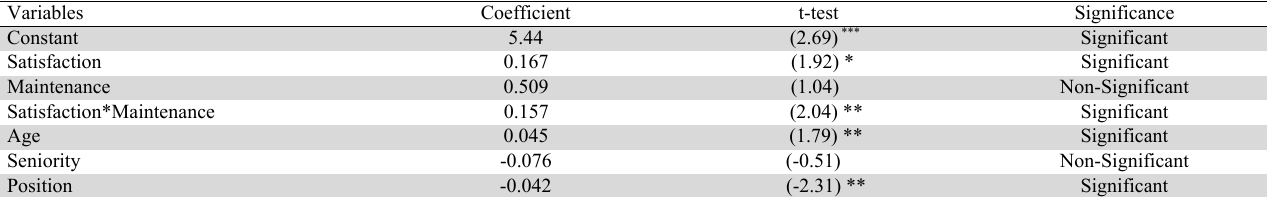
Dependent variable: contextual